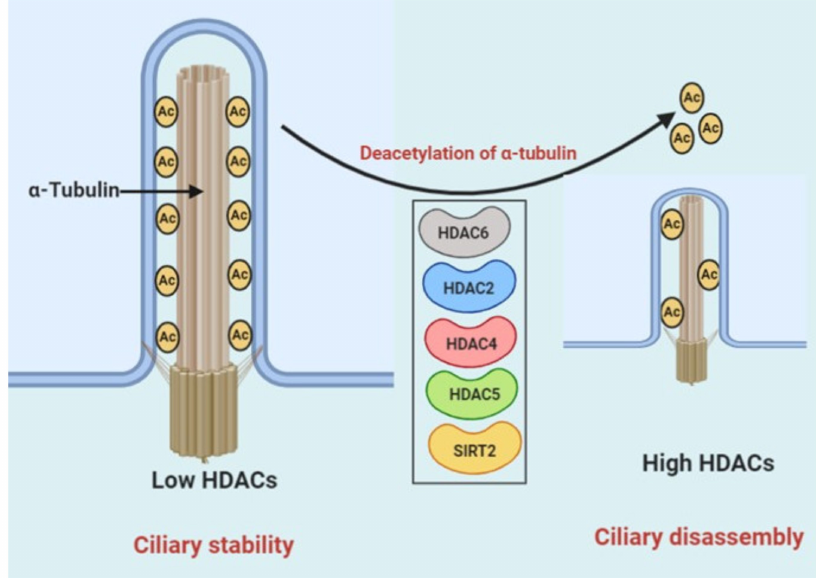
Figure 4. Working model for the role of HDACs in ciliary disassembly. Ciliary disassembly is mediated through deacetylation of α -tubulin in the ciliary axoneme mediated by HDACs. Removal of acetyl groups from α -tubulin destabilizes axoneme microtubules, promoting ciliary resorption. HDACs Inhibitors (HDACis) and